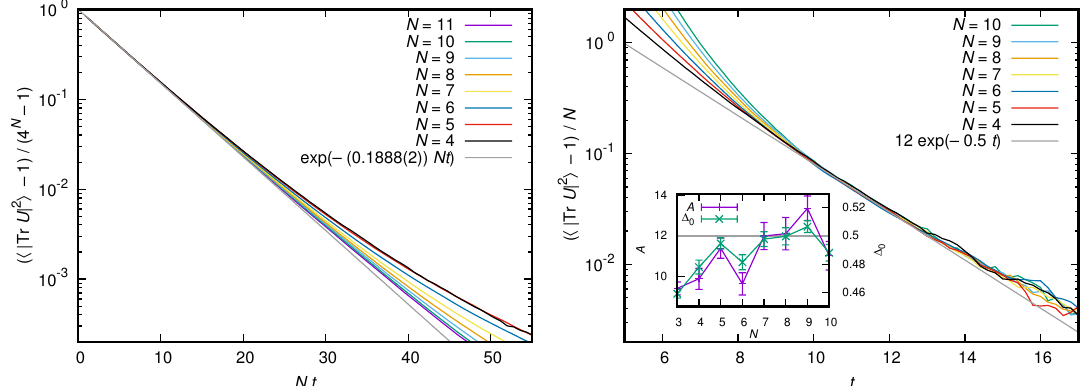
Figure 18 . [Left] Plot of ( hj Tr U j 2 i (cid:0) 1) = (4 N (cid:0) 1) against Nt for the RCQ chain with dt = 0 : 2 for N = 11 ; 10 ; 9 ; 8 ; 7 ; 6 ; 5 ; 4 qubits. The result of a single parameter (cid:12)t by an exponential function of Nt is also shown. [Right] Plot of ( hj Tr U j 2 i (cid:0) 1) =N against t for the RCQ chain with dt = 0 : 2 for N = 10 ; 9 ; 8 ; 7 ; 6 ; 5 ; 4 qubits. The inset shows the result of (cid:12)t for t 2 [10 : 14] with Ae (cid:0) (cid:1) 0 t by taking A and (cid:1) 0 as (cid:12)tting parameters. The line corresponding to ( A; (cid:1) 0 ) = (12 ; 0 : 5) is also shown in the main plot.